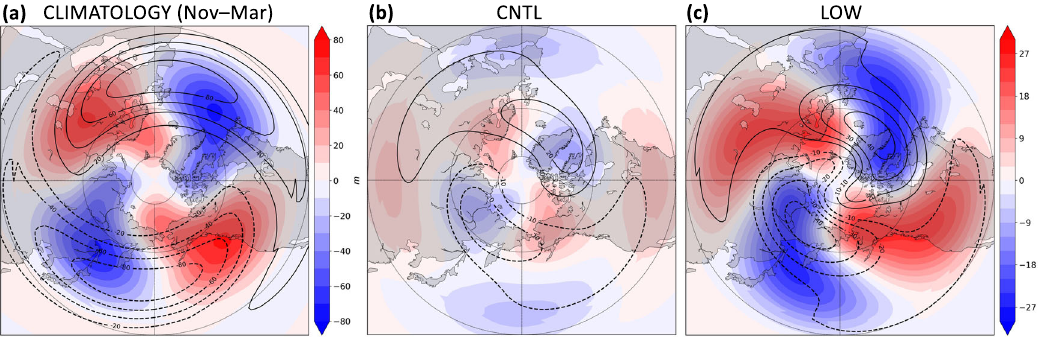
Fig. 9 Planetary wave interference. WN1 (line contours) and WN2 ( fi lled contours) components of the 500-hPa geopotential height (m) for November – March mean climatology ( a ) and composite anomalies averaged from day − 10 to day − 1 prior to the onset in CNTL ( b ) and LOW ( c ). (suppressed). The left column of Fig. 9 shows the climatological WN1 (line contours) and WN2 ( fi lled contours) components of the extended wintertime 500-hPa geopotential height. The corre- sponding anomalous fi eld in CNTL and LOW are illustrated in the